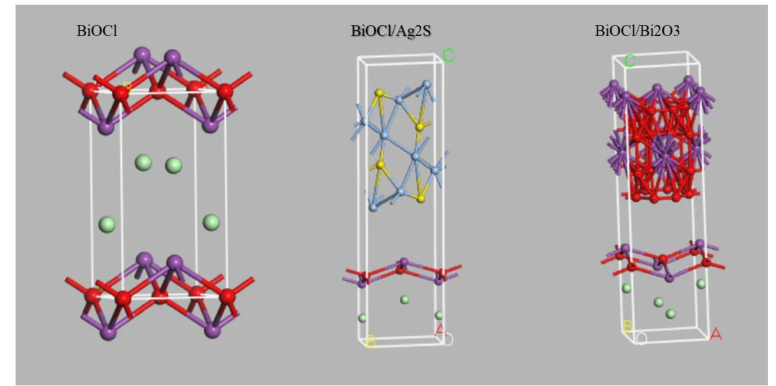
Figure 1. Molecular structure of: A BiOCl B BiOCl/Ag 2 S, and C BiOCl/Bi 2 O 3 .